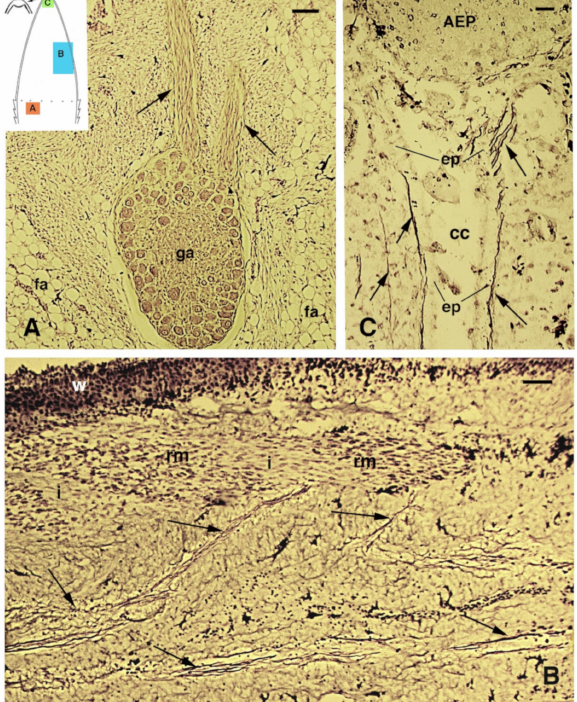
Figure 4. Bodian staining of spinal ganglia ( A ) and nerves ( B , C ) innervating the regenerating tail in P. muralis . ( A ) Ganglion with two main nerve bundles (arrows) directed into the elongating cone (15 days post-autotomy), and the position of which is indicated in the drawing ( A ). Bar, 50 µ m. ( B ) Numerous nerves (arrows) innervate the regenerating tail (see the indicative position in ( B ) of the drawing), including the regenerating segmental muscles. Bar, 20 µ m. ( C ) Detail of the few nerves reaching the apical ependymal ampulla that is present underneath the apical epidermal peg (indicative position in ( C ) of the drawing). Bar, 10 µ m. Legends: AEP, apical epidermal peg; cc, central canal of the ependyma; ep, ependymal canal; fa, fat cells; ga, spinal ganglion; i, inter-muscular connective tissue; rm, regenerating